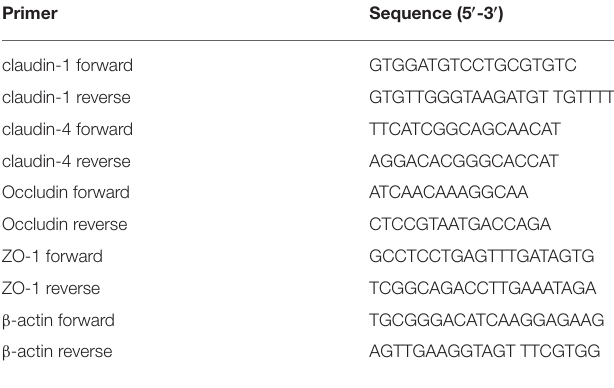
TABLE 1 | Primer sequence. Primer Sequence (5 ′ -3 ′ )